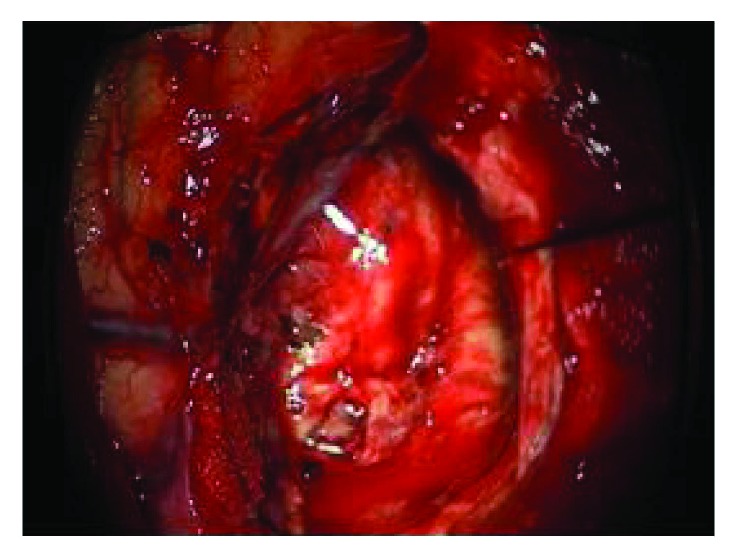
Real neurosurgery.